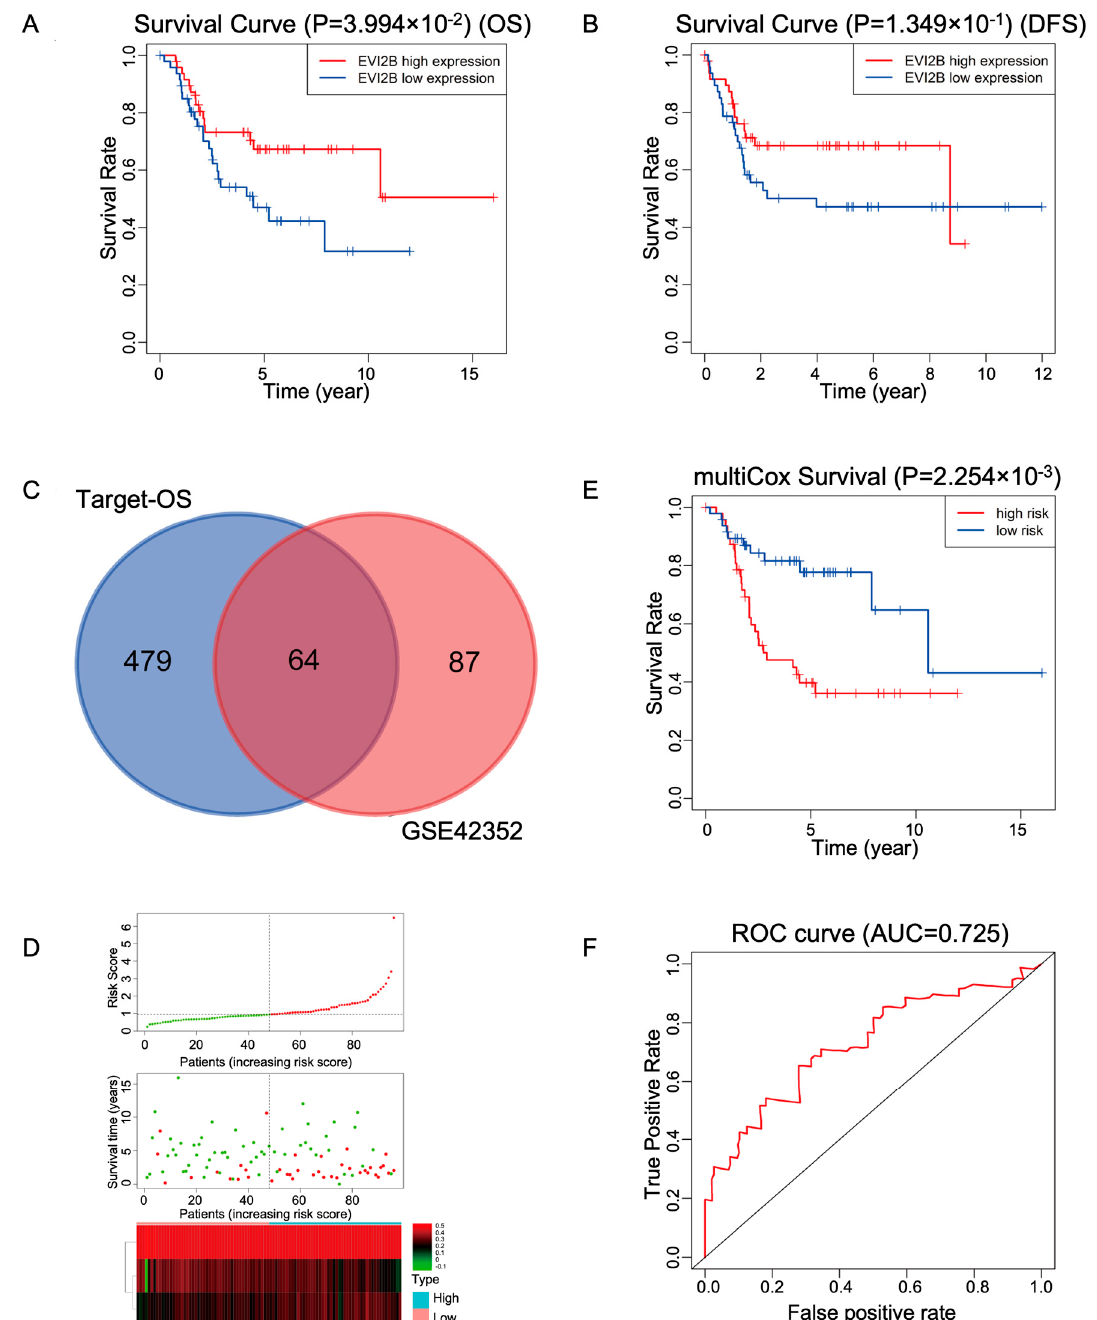
Figure 4. The prognostic value of EVI2B and the construction of a prediction model in osteosarcoma. ( A ) Effect of EVI2B on overall survival (OS) in osteosarcoma. ( B ) Effect of EVI2B on disease-free survival (DFS) in osteosarcoma. ( C ) Venn diagram showing the intersection between the differentially expressed genes in the test set with those in the validation set. ( D ) Risk curve of the three-gene set ( top ), survival state ( middle ), and risk heat map ( bottom ). ( E ) The three-gene set ( EVI2B, DOCK2, and CD33 ) was a significant determinant prognosis based on overall survival in osteosarcoma, as determined by a multivariate Cox analysis. EVI2B and DOCK2 are highly expressed and CD33 is lowly expressed in low-risk group. EVI2B and DOCK2 are lowly expressed and CD33 is highly expressed in high-risk group. ( F ) ROC curve analysis of the accuracy of the model for the prediction of survival and prognosis in osteosarcoma.